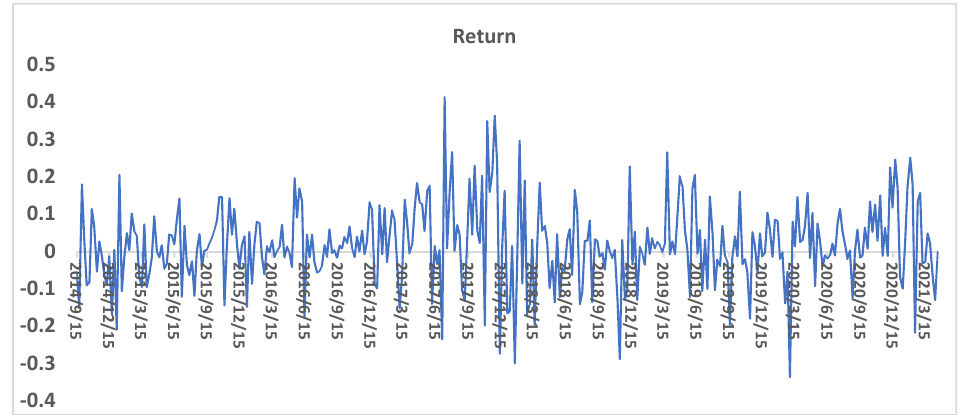
Figure 1. Bitcoin monthly return volatility from a period of six years between 15 September 2014 to 15 September 2021.